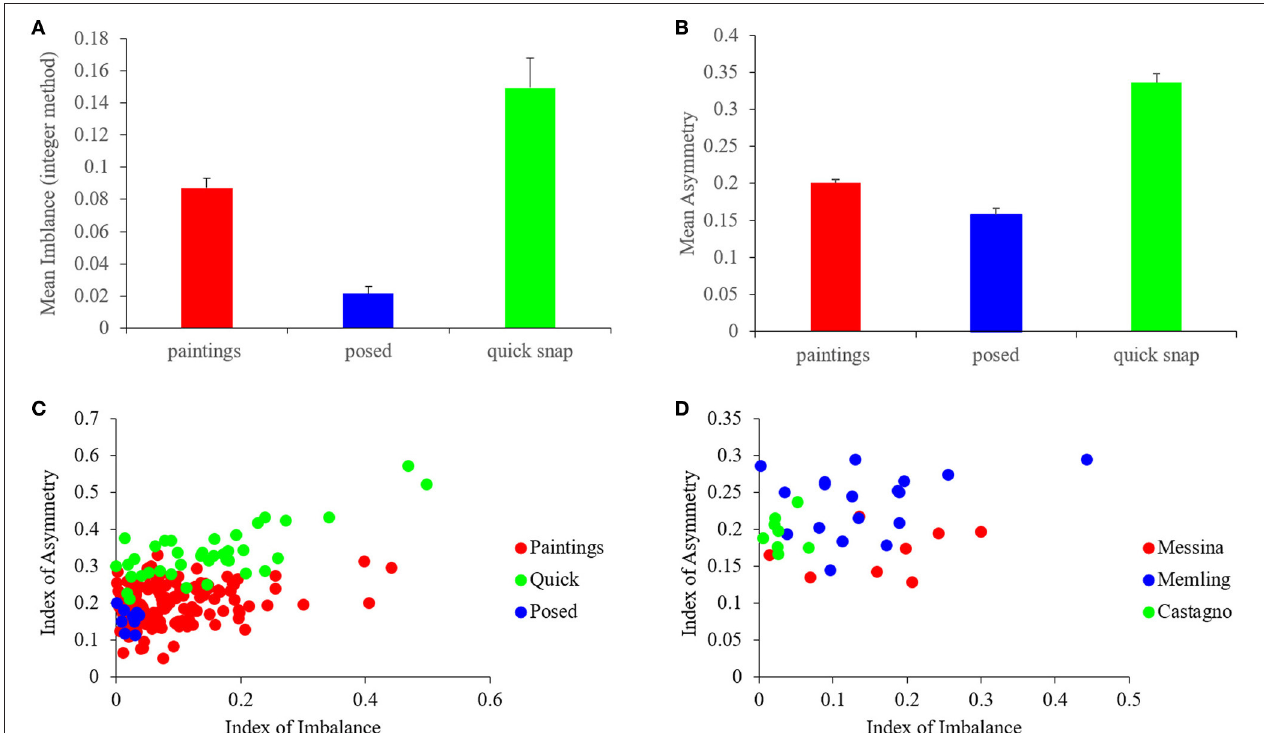
FIGURE 4 | Quantification of the Asymmetry and imbalance Indices. (A,B) Mean and standard error of the Indices of Imbalance (Equation 4) and Asymmetry (Equation 1) respectively for the different categories of images. Artists balanced and symmetrized paintings more than quickly snapped photographs, but not as well as in frontally posed controls. (C) Scatterplots of the Indices of Asymmetry vs. the Indices of Imbalance for 153 paintings, 38 quickly snapped photographs, and 9 frontally posed. Both paintings and quickly snapped photographs exhibited positive correlations, while posed controls did not. (D) Same plot as in C but for three example artists, namely, Antonello da Messina, Hans Memling, and Andrea del Castagno. The indices for these artists cluster in different small sub-regions of the